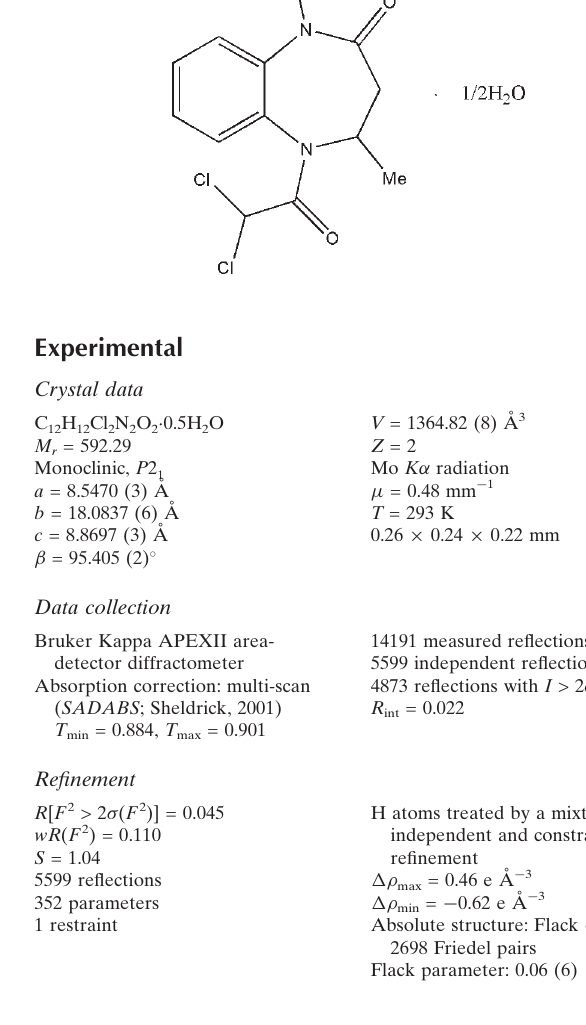
Data collection Bruker Kappa APEXII area- detector diffractometer